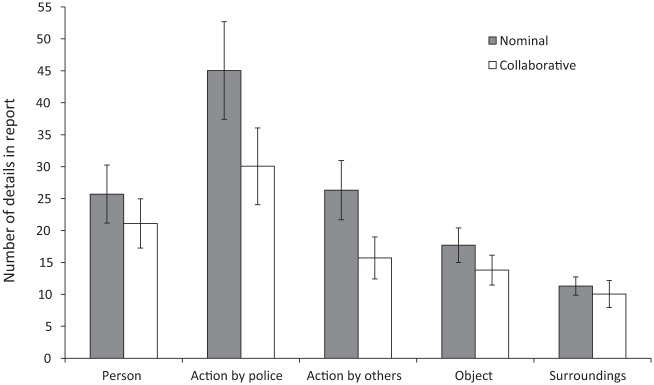
Average Number of Details Per Type of Detail in First Reports Written by Nominal Pairs and Collaborative PairsNote. Error bars depict 95% confidence intervals.